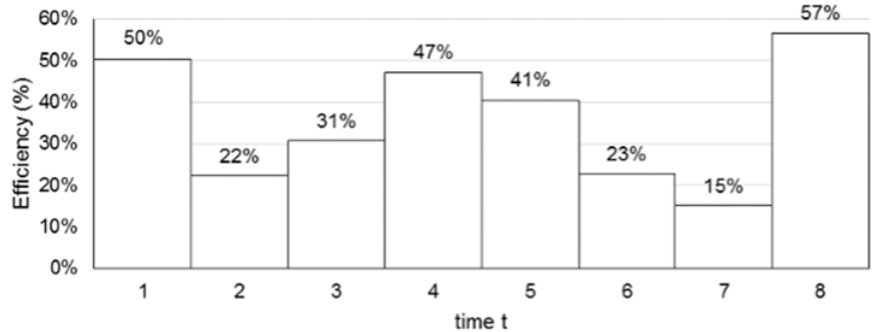
Figure 8. Scenario (b) Solar collector efficiency.